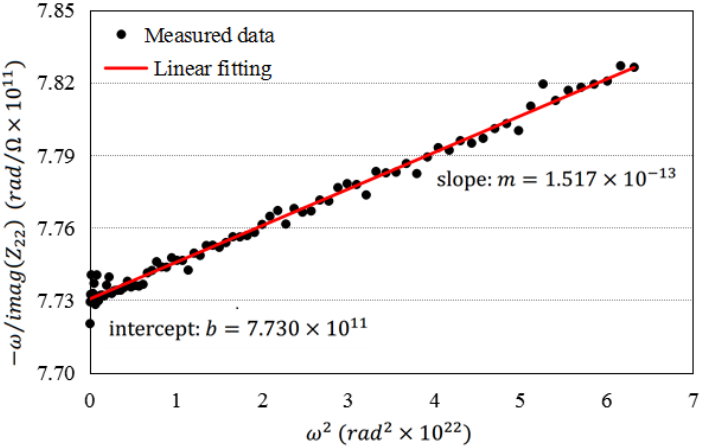
Figure 2. Measured data and linear regression to calculate C x and R ch for a